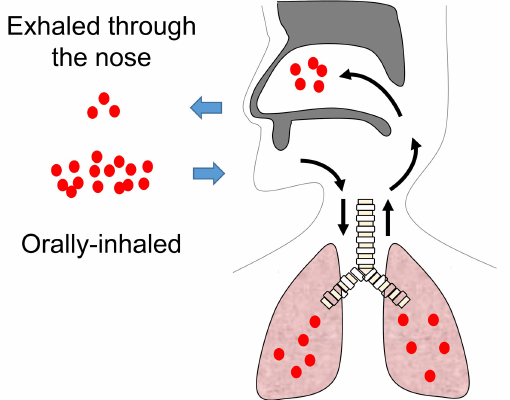
Figure 3. Schema of HFA-BDP ETN treatment; hydrofluoroalkane-134a-beclomethasone